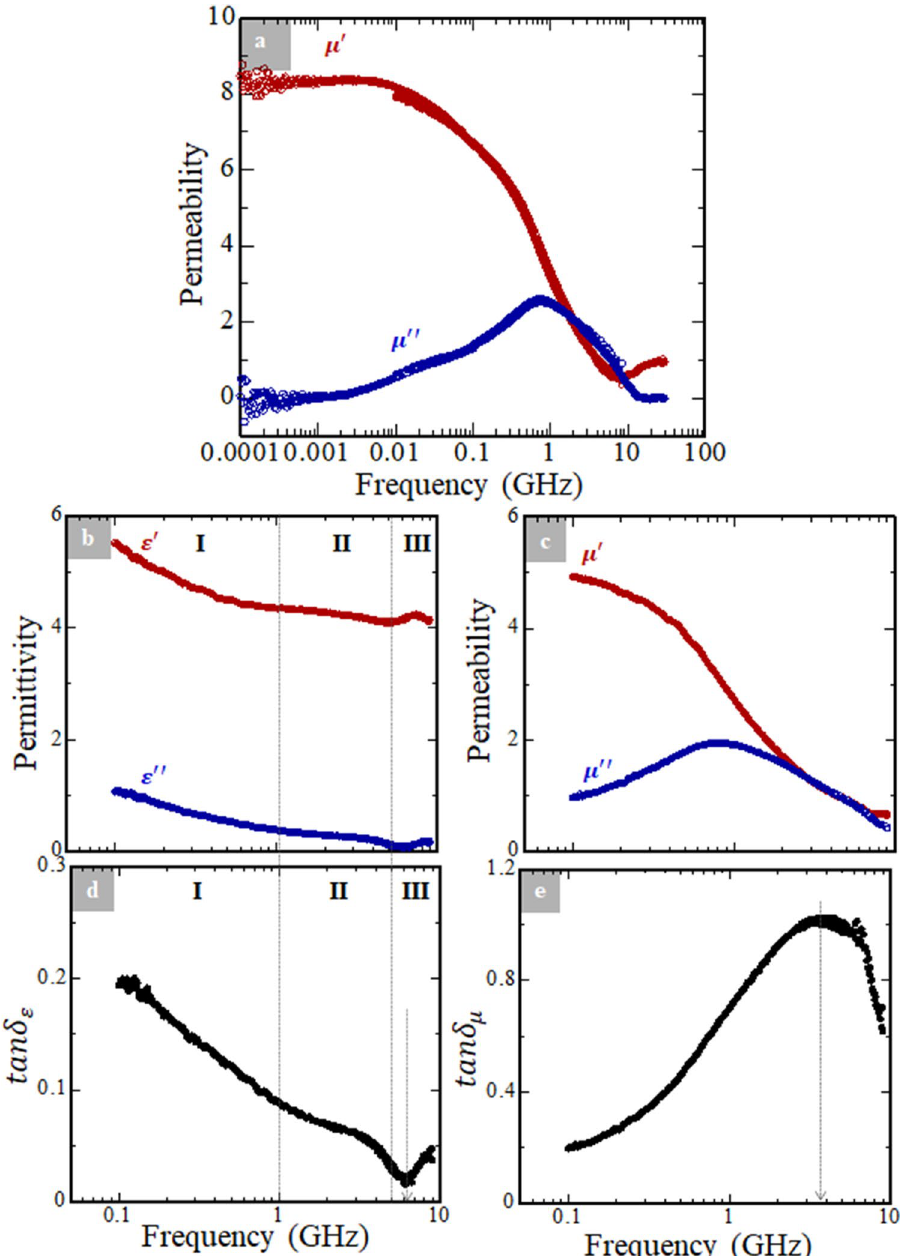
Figure 3. ( a ) Frequency dependence of dynamic permeability evaluated through the short-circuited MSL method. The maximum frequency of irradiated electromagnetic wave is 30 GHz. Frequency dependences of ( b ) the complex permittivity and ( c ) the complex permeability measured by means of a network analyzer in the frequency range of 0.1–9 GHz. For these measurements, the present Ni 0.5 Zn 0.5 Fe 2 O 4 powder/polymer composite ′′ tan δ µ = µ ′′ sheet was fabricated as a toroidal shape. ( d ) The tan δ ε = ε ε ′ , and ( e ) µ ′ , respectively, calculated using the results obtained from ( b ) and ( c ),